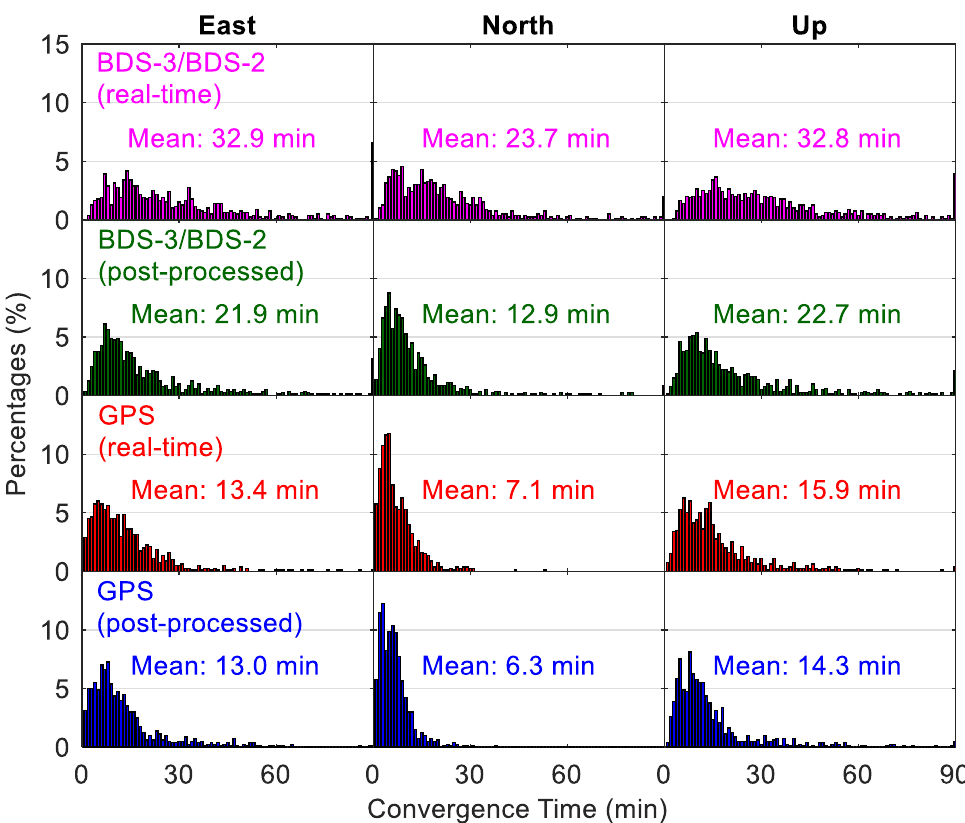
Figure 15. Distribution of convergence time from different static PPP solutions.